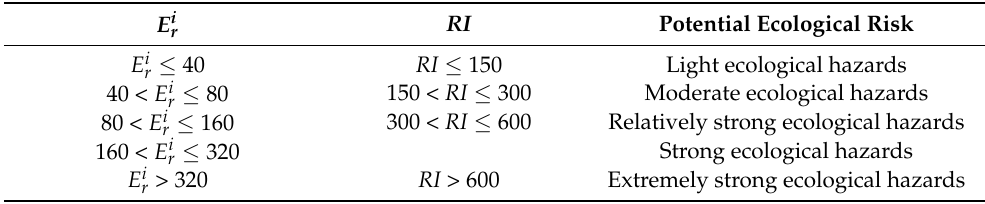
Table 2. Corresponding range of ecological risk level in soil. E i